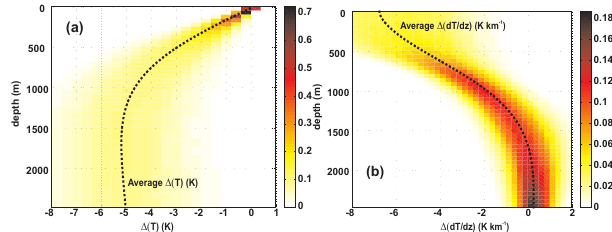
Fig. 3. Using prior knowledge for correction of shallow borehole temperature profiles. (a) Inversion of BTP of different lengths de- rived from a synthetic GSTH (shown in grey), which shows constant temperatures since the postglacial temperature rise. (b) Boreholes were corrected by subtracting the response to this prior GSTH. The shallowest BTP (250m, dark blue) is too short to resolve the LIA- like structure, and thus the results show only very weak effects, in- dependent of whether input data are raw or corrected. A regular- ization parameter of 0.25 was used in this numerical